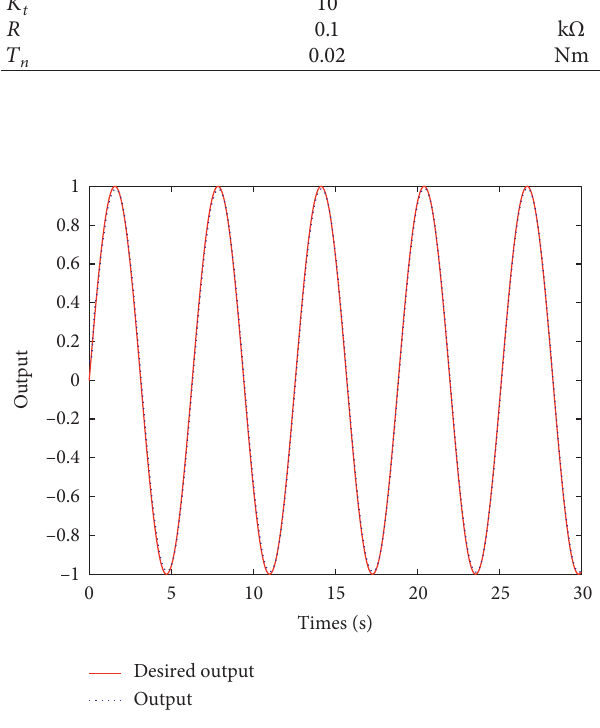
Figure 3: The control results with small input signal amplitude.